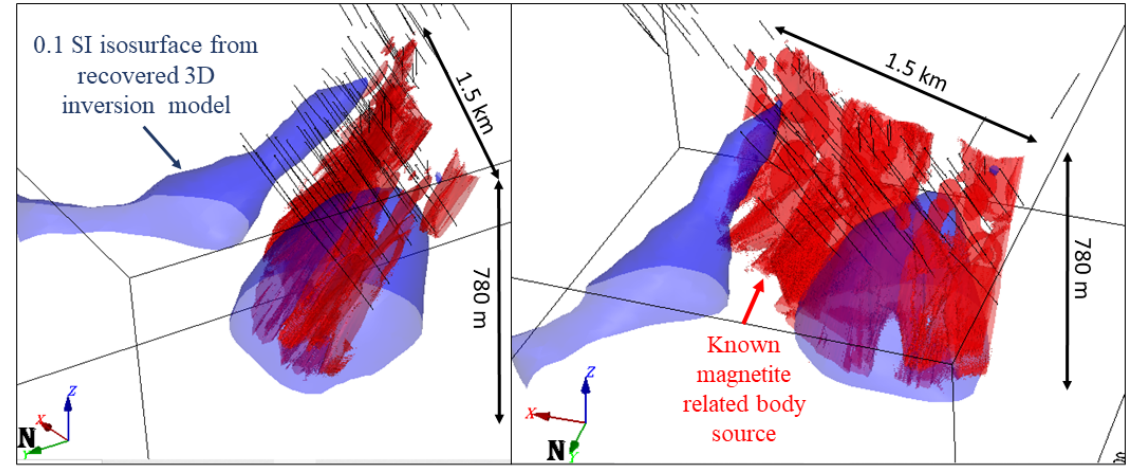
Figure 9. Correlation between the 0.1 SI isosurface from the recovered 3D-induced magnetization inversion model in blue and the known magnetite related body source from the high magnetic susceptibility model performed in this study that will be further explained in red. Drill holes in black traces. Views from northwest to southeast.